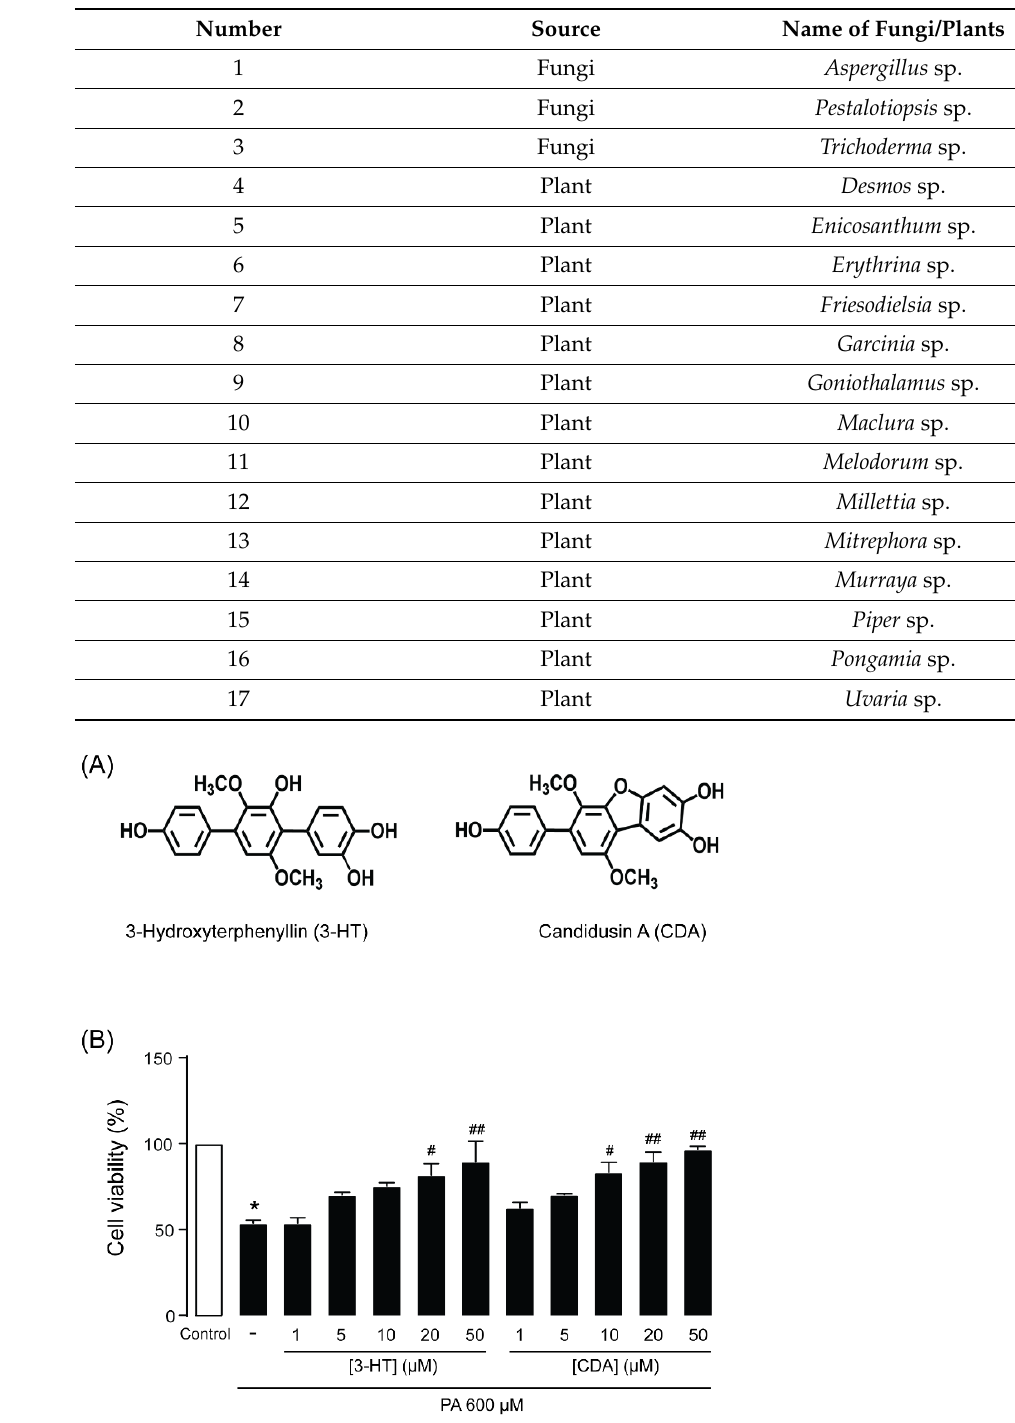
Figure 2. ( A ) The chemical structure of fungus-derived 3-hydroxyterphenyllin (3-HT) and can- didusin A (CDA). ( B ) 3-HT and CDA protected against palmitic acid (PA)–induced podocyte death. Podocytes were cultured in RPMI 1640 medium containing 600 µ M PA in the presence of 3-HT or CDA (1–50 µ M) for 24 h. Cell viability was assessed with the MTT assay. The data are expressed as the mean ± standard error of the mean ( n = 4). * p <0.05 compared with control; # p < 0.05 compared with PA; ## p < 0.01 compared with PA.